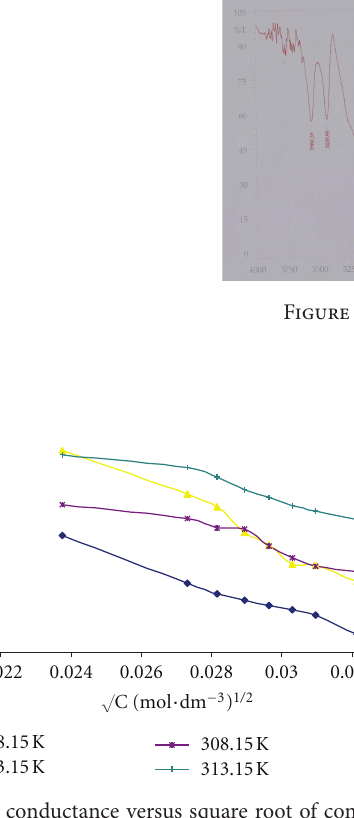
F 2: Molar conductance versus square root of concentration for Ba-succinate at different temperatures.